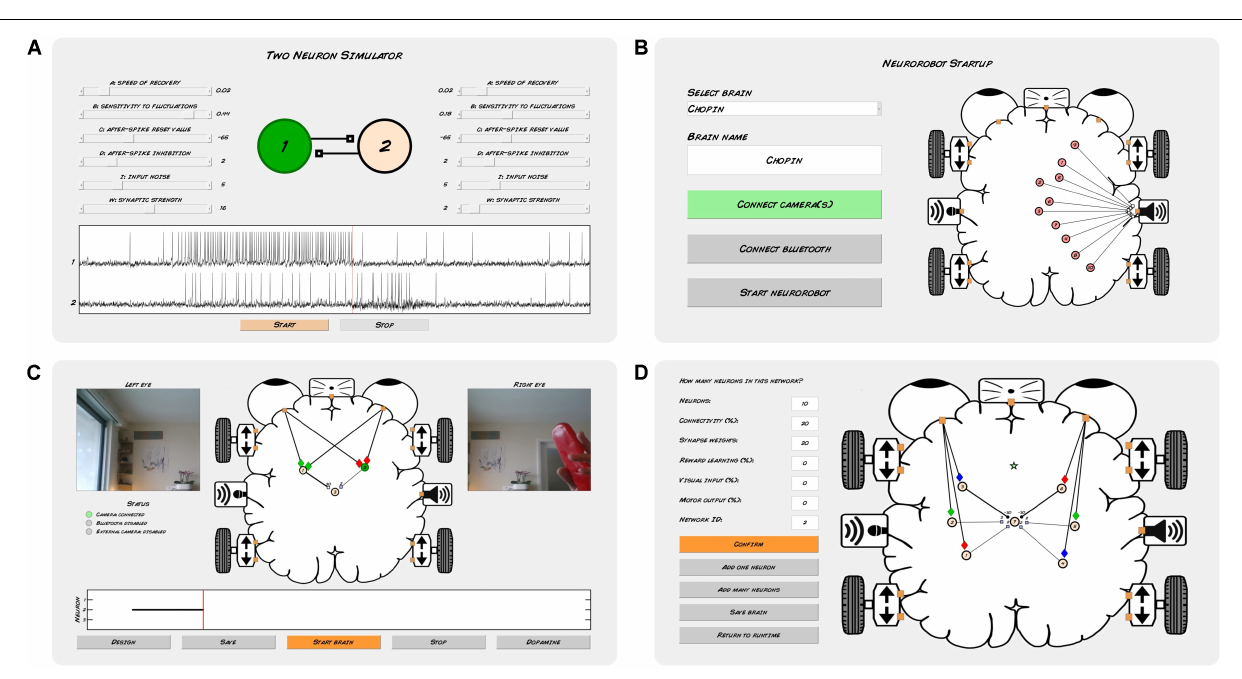
FIGURE 2 | Neurorobot app. (A) Two Neuron Simulator. (B) Startup mode. (C) Runtime mode. (D) Brain design